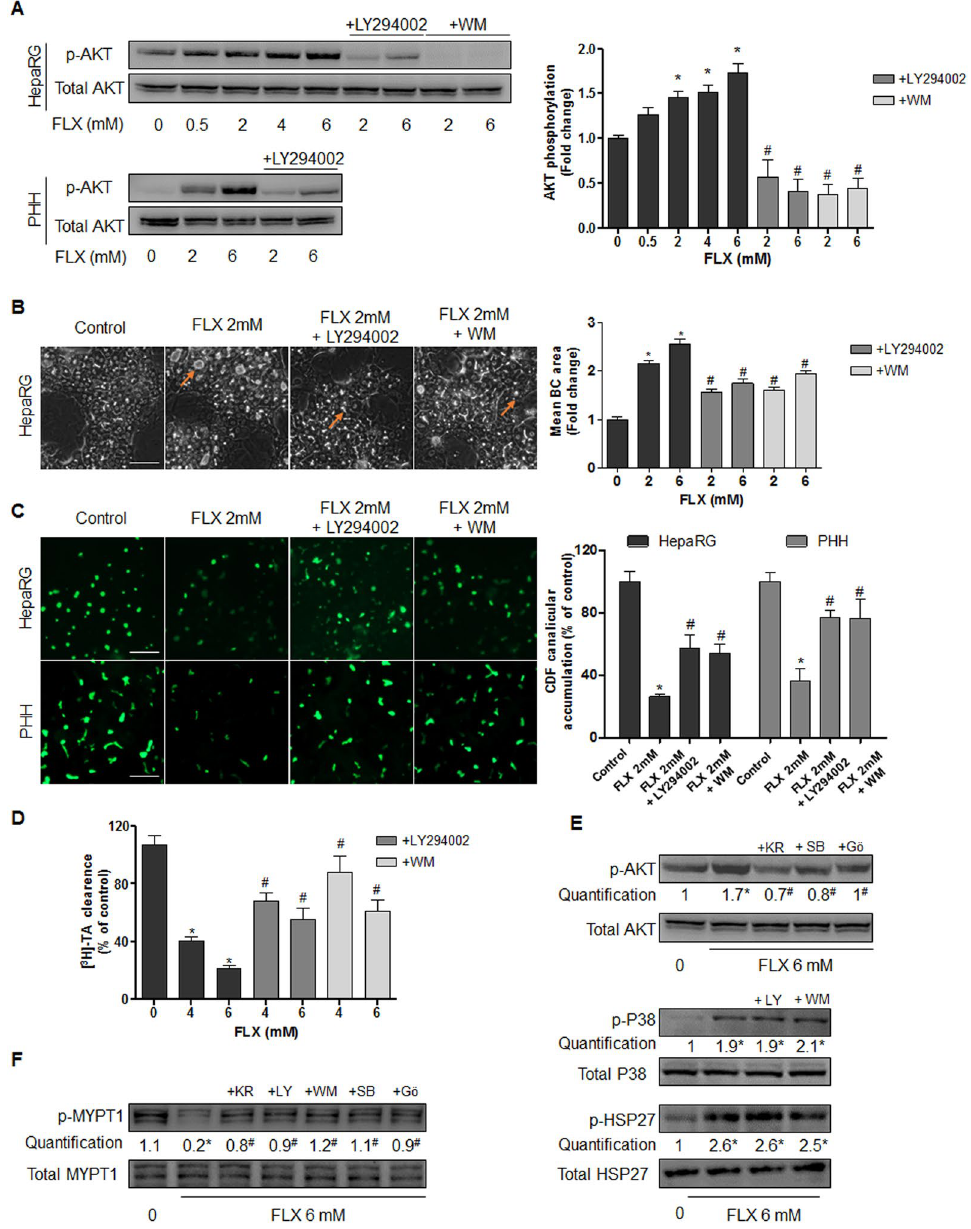
Figure 7. Involvement of PI3K/AKT pathway in FLX-induced effects. ( A ) Representative western blots of p-AKT/total AKT forms after 2h-treatment with FLX (0–6 mM) alone or combined with the PI3K inhibitors LY294002 (10 µ M) or WM (0.25 µ M) in HepaRG cells and PHH. Quantification of p-AKT in HepaRG cells using ImageJ 1.48 software. ( B ) Representative phase-contrast images of HepaRG cells treated for 2 h with 2 mM FLX alone or combined with 10 µ M LY294002 or 0.25 µ M WM. Quantification of BC area using ImageJ 1.48 software. Orange arrows indicating BC deformation (bar = 50 μ m). ( C ) CDF efflux in HepaRG hepatocytes and PHH treated for 2 h with 2 mM FLX alone or combined with 10 µ M LY294002 or 0.25 µ M WM. Quantification of CDF accumulation in BC of HepaRG hepatocytes and PHH, using ImageJ 1.48 software. ( D ) [ 3 H]-TA clearance in HepaRG cells treated with 4 or 6 mM FLX alone or co-treated with 10 µ M Y294002 or 0.25 µ M WM for 2 h. ( E ) Representative western blots of p-AKT/total AKT forms after 2 h treatment with 6 mM FLX alone or combined with 0.5 µ M HSP27 inhibitor (KRIBB3; KR), 10 µ M P38 inhibitor (SB203580; SB), and 20 µ M PKC inhibitor (Gö6976; Gö). Representative western blots of p-P38/total P38 and p-HSP27/total HSP27 after 2 h treatment with 6 mM FLX alone or combined with the PI3K inhibitors 10 µ M LY294002 (LY) or 0.25 µ M WM. ( F ) Representative western blots of p-MYPT1/total MYPT1 after 4 h treatment with 6 mM FLX alone or combined with KR, LY, WM, SB or Gö. The displayed blots were cropped and the original full-length gels are included in the supplementary information. Data were expressed relative to those of untreated cells arbitrarily set at 1 or 100%. They represent the means ± SEM of 3 independent experiments. * p < 0.05 compared with that of untreated cells, # p < 0.05 compared with that of cultures treated with FLX